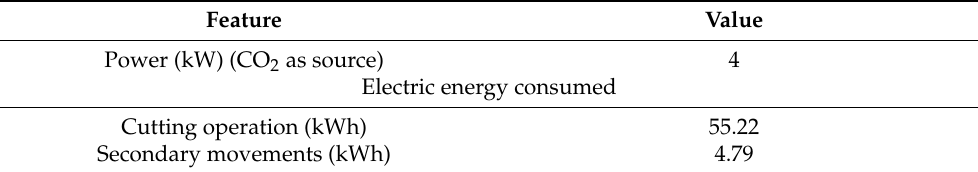
Table 18. Laser-cutting equipment’s main features necessary for the CF calculation [70].